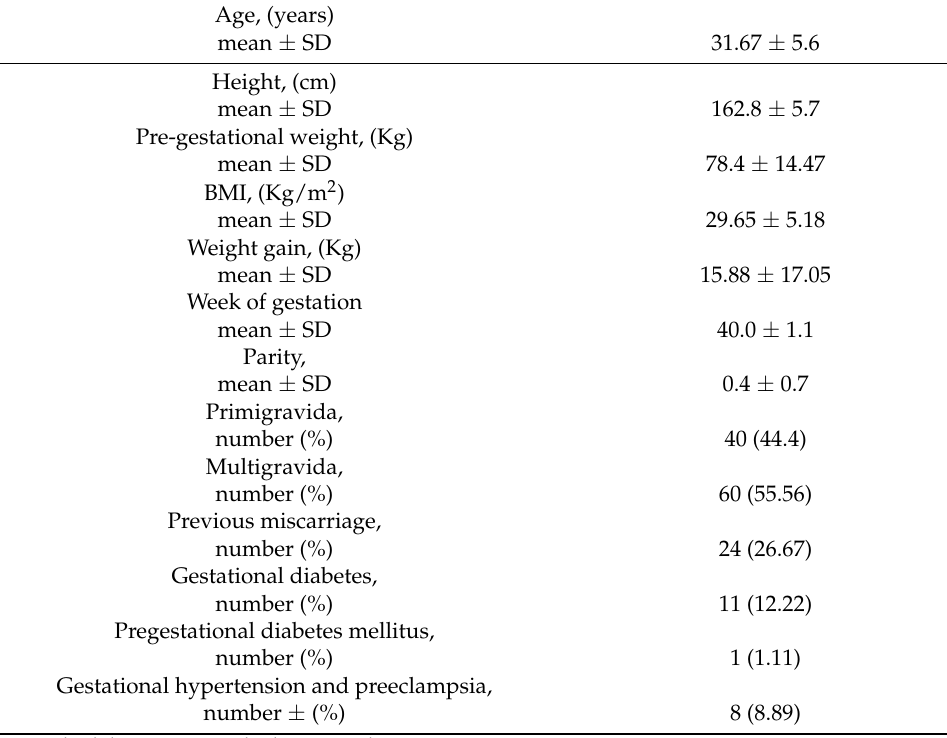
Table 1. Demographic data of the study participants (n =